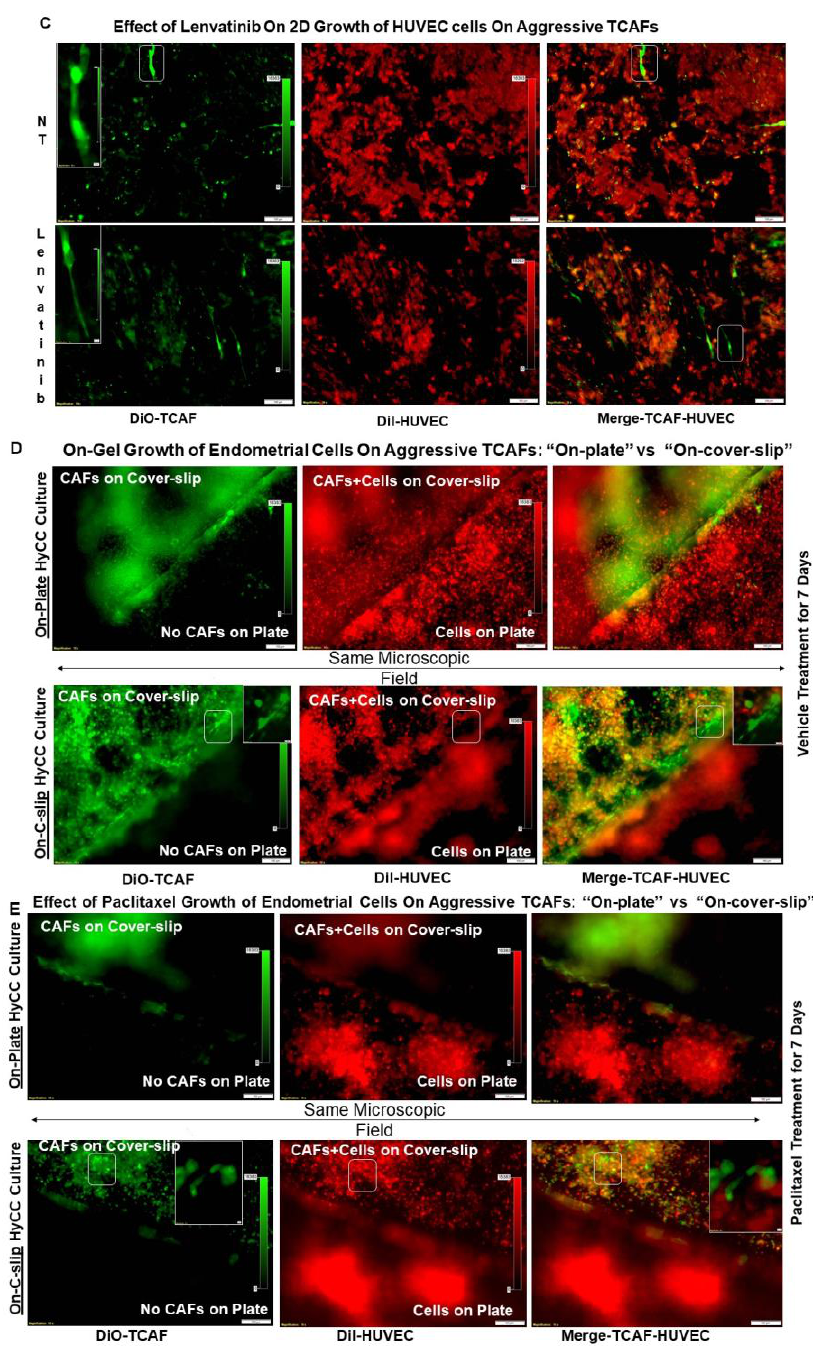
Figure 6. Effect of aggressive CAFs from a patient with PSE on the paclitaxel-mediated inhibition of clonogenic growth of endometrial cancer cells and on the lenvatinib-mediated inhibition of HUVEC growth in hybrid-co-cultures using different formats: Primary culture of aggressive CAFs (passage # 2) from a patient with PSE was stained with DiO and plated on matrigel 24 h before DiI stained AN3CA endometrial cells were added in the 3D On-Top clonogenic cultures with or without 20 nM paclitaxel. Parallel experiments were run without CAFs. Pictures were taken at 20X/40X dry-objective of Olympus BX43 Microscope using cellSens 1.18 LIFE SCIENCE IMAGING SOFTWARE (OLYMPUS CORPORATION). Photomicrographs show the information stamps for magnifications and the scale bars. Growth (2D) of DiI-stained AN3CA endometrial cells in HyCC without coverslips on DiO-stained aggressive endometrial TCAFs with PSE in the presence and absence of paclitaxel for 7 days ( A ), on-gel growth of DiI-stained AN3CA endometrial cells in HyCC without coverslips on DiO-stained aggressive endometrial TCAFs with PSE in the presence and absence of paclitaxel for 7 days ( B ), no-gel-growth of DiI-stained HUVEC (passage # 3) in HyCC on DiO-